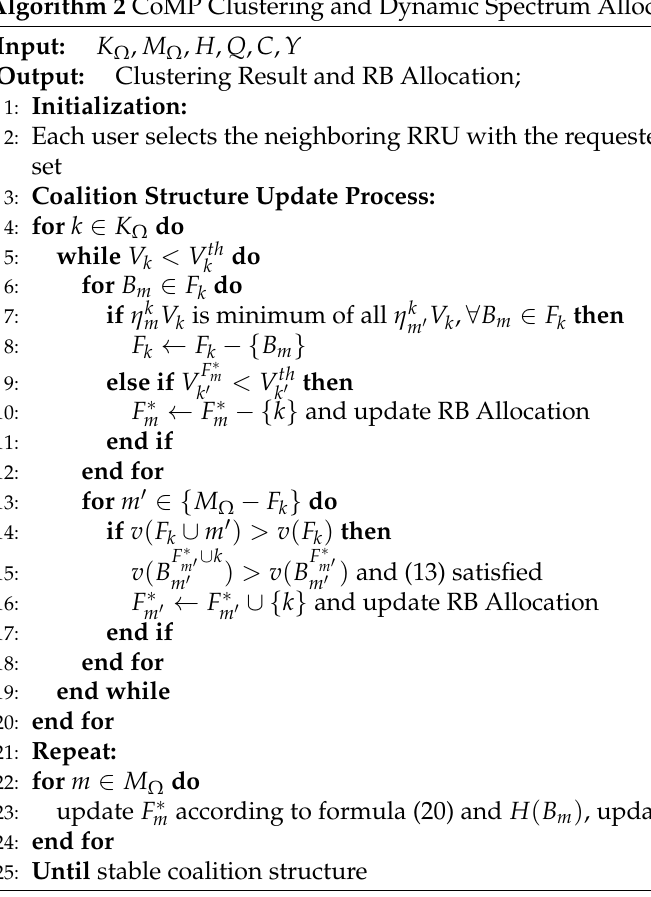
Algorithm 2 CoMP Clustering and Dynamic Spectrum Allocation